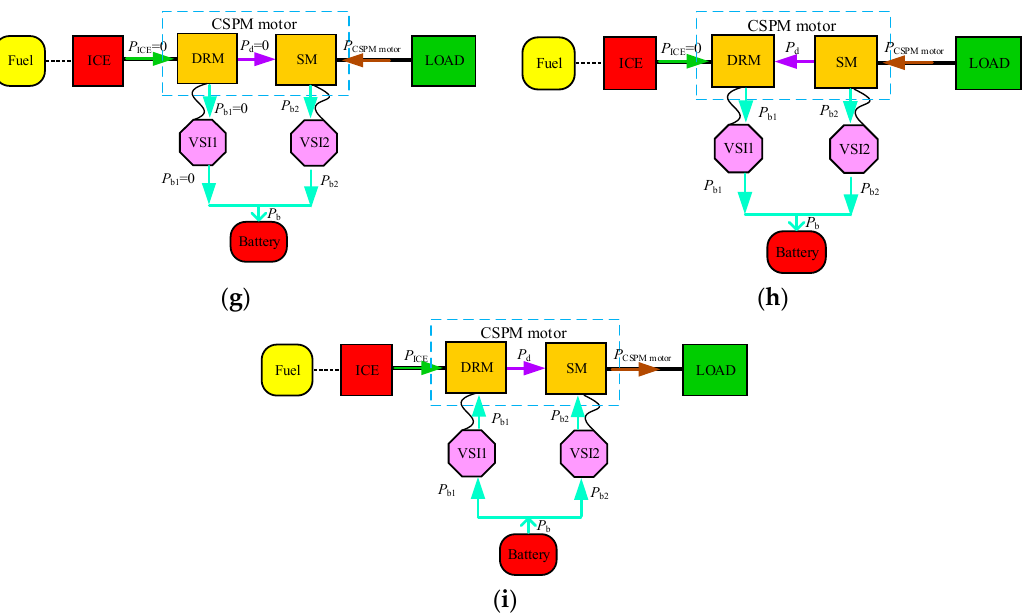
Figure 2. Power flow process of HEVs based on CSPM motor in different working mode: ( a ) pure electric mode; ( b ) CVT mode; ( c ) auxiliary power mode; ( d ) driving and parking generation mode; ( e ) driving and parking generation mode; ( f ) electric braking mode; ( g – h ) regenerative braking mode; ( i ) over-speed mode.